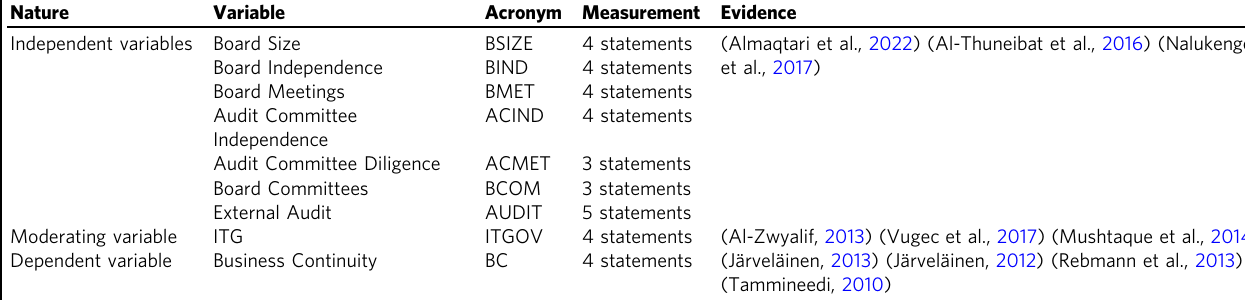
Table 2 Operational de fi nition of the variables.